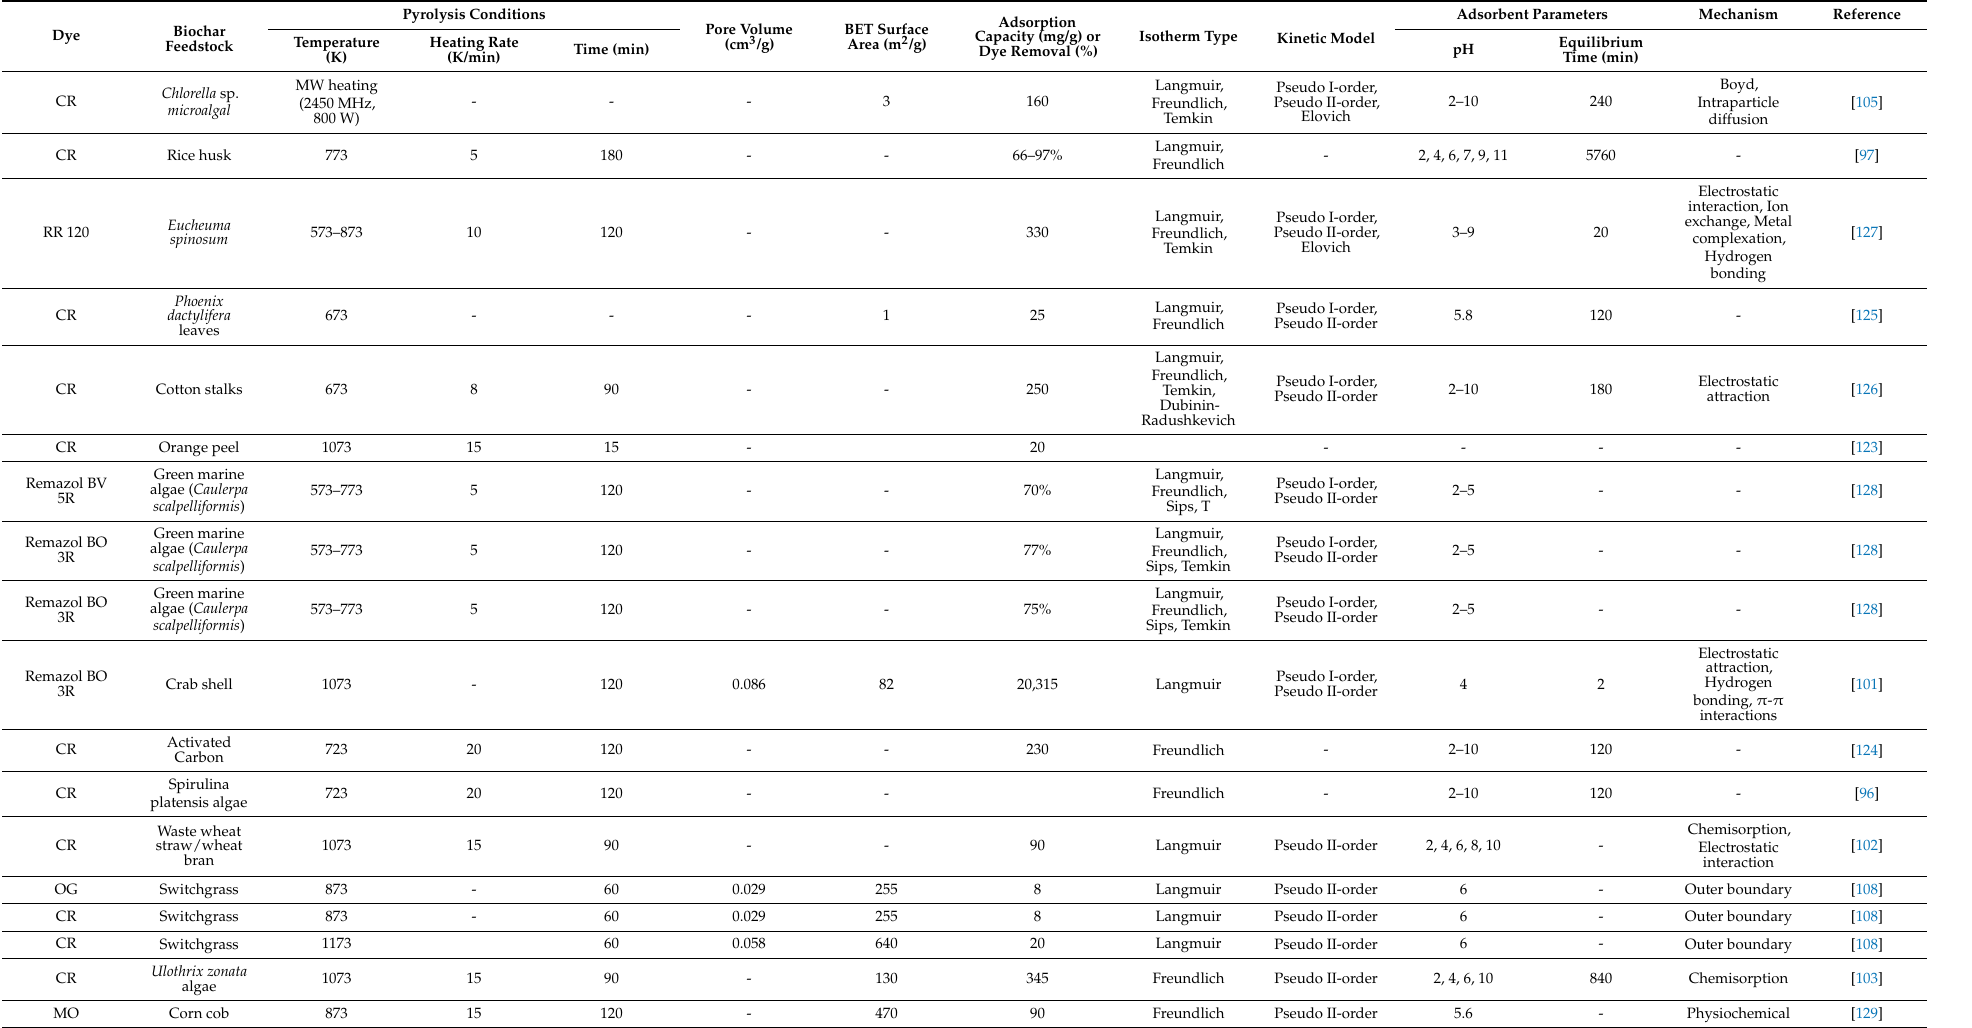
Table 2. Acid dyes (anionic) and their adsorption onto